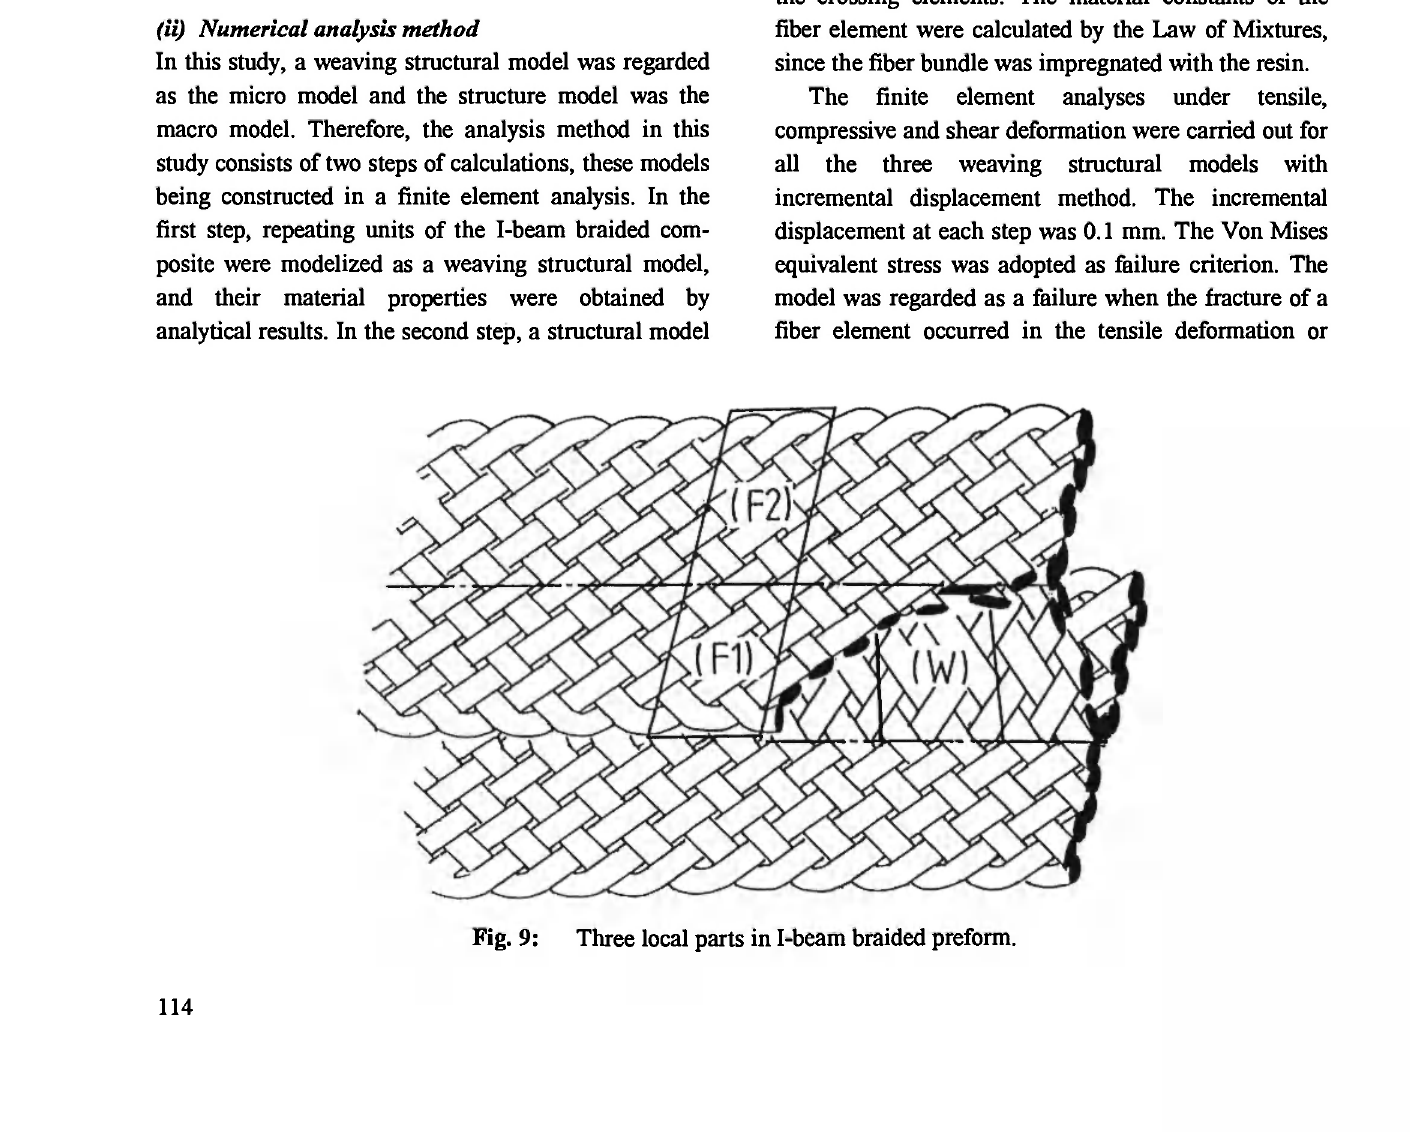
Fig. 9: Three local parts in I-beam braided